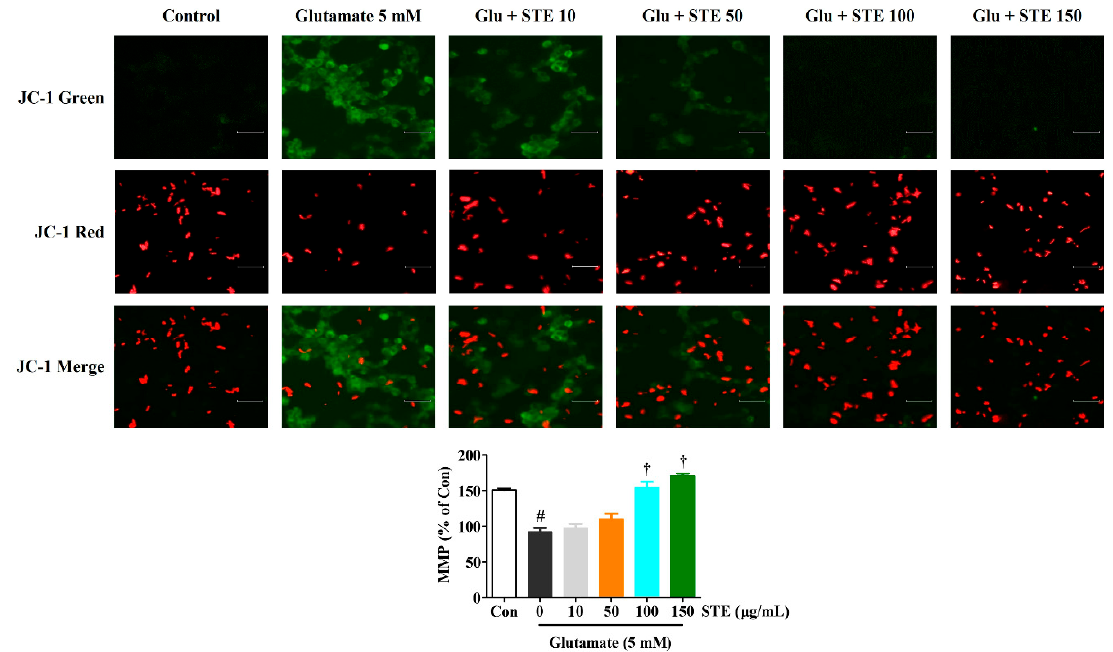
Figure 4. Effects of Selaginella tamariscina ethanol extract (STE) on glutamate-induced mitochondrial dysfunction in HT22 cells. The mitochondrial membrane potential (MMP) was assessed by microscopy using JC-1 staining. Images represent three independent experiments at a magnification of 200 × . Scale bar = 100 µ m. Red fluorescence indicated normal MMP; green fluorescence indicated damaged mitochondria with MMP loss. The histogram shows the red/green fluorescence intensity ratio. Control cells were incubated with the vehicle alone. Data are presented as mean ± standard error of the mean of three independent experiments. Glu, glutamate; Con, control. Statistical significance was defined as # p < 0.05 (vs. control) and † p < 0.001 (vs. glutamate).